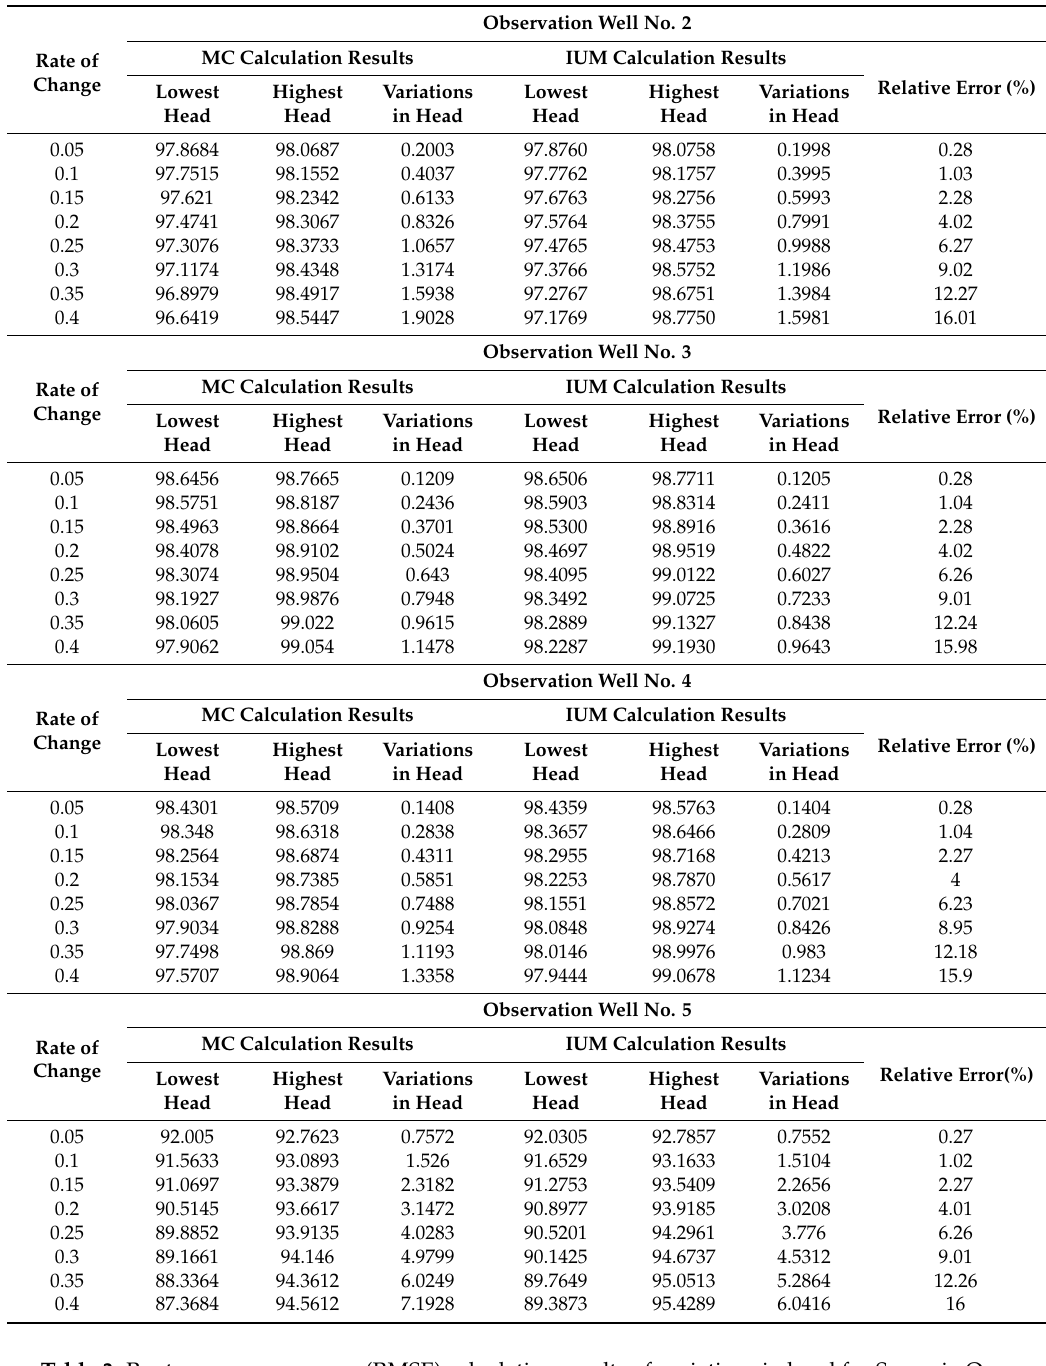
Table 3. Root mean square error (RMSE) calculation results of variations in head for Scenario One. Rate of